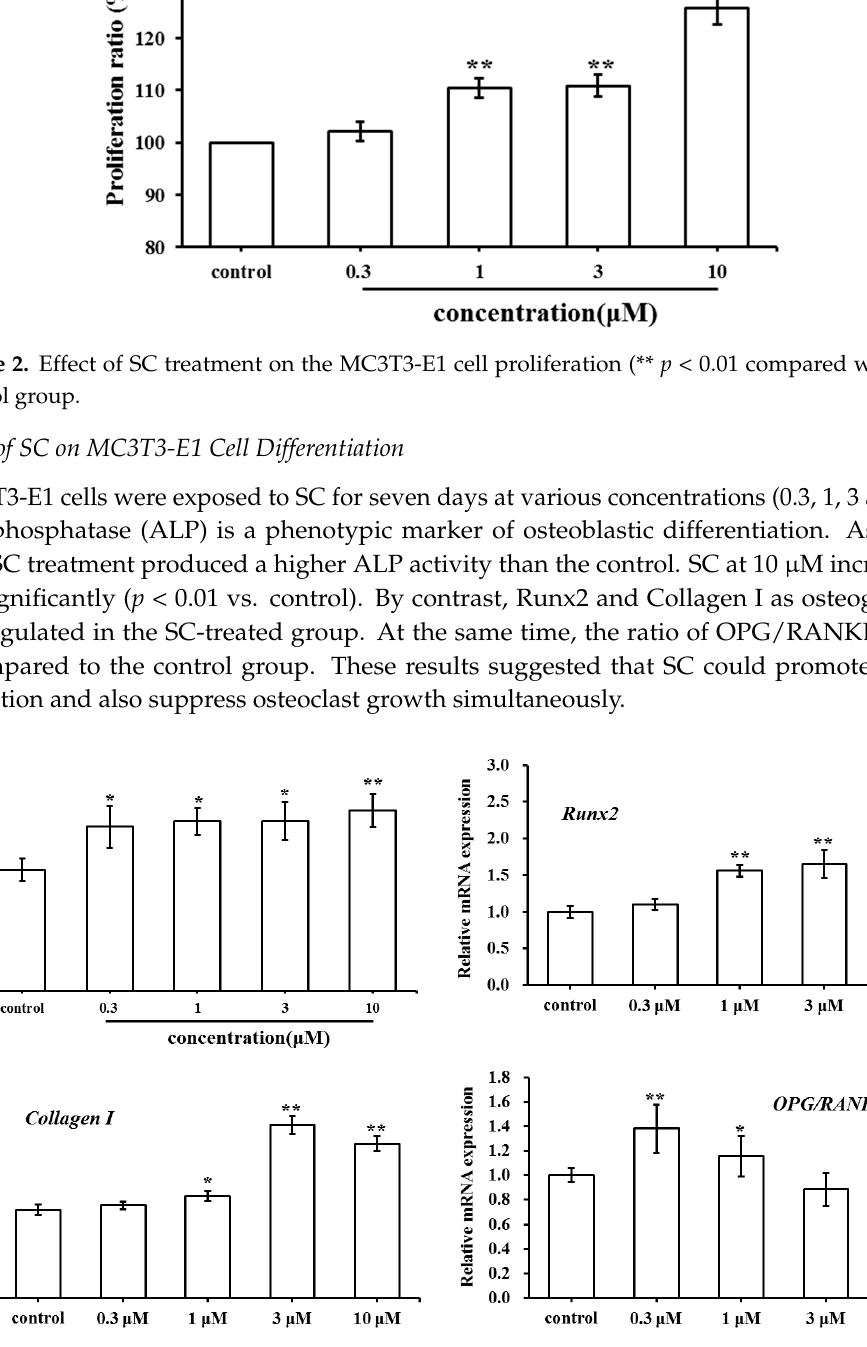
Figure 3. Effect of SC treatment on ALP activity and relative mRNA expression of osteogenic genes (* p < 0.05, ** p < 0.01 compared with the control group).